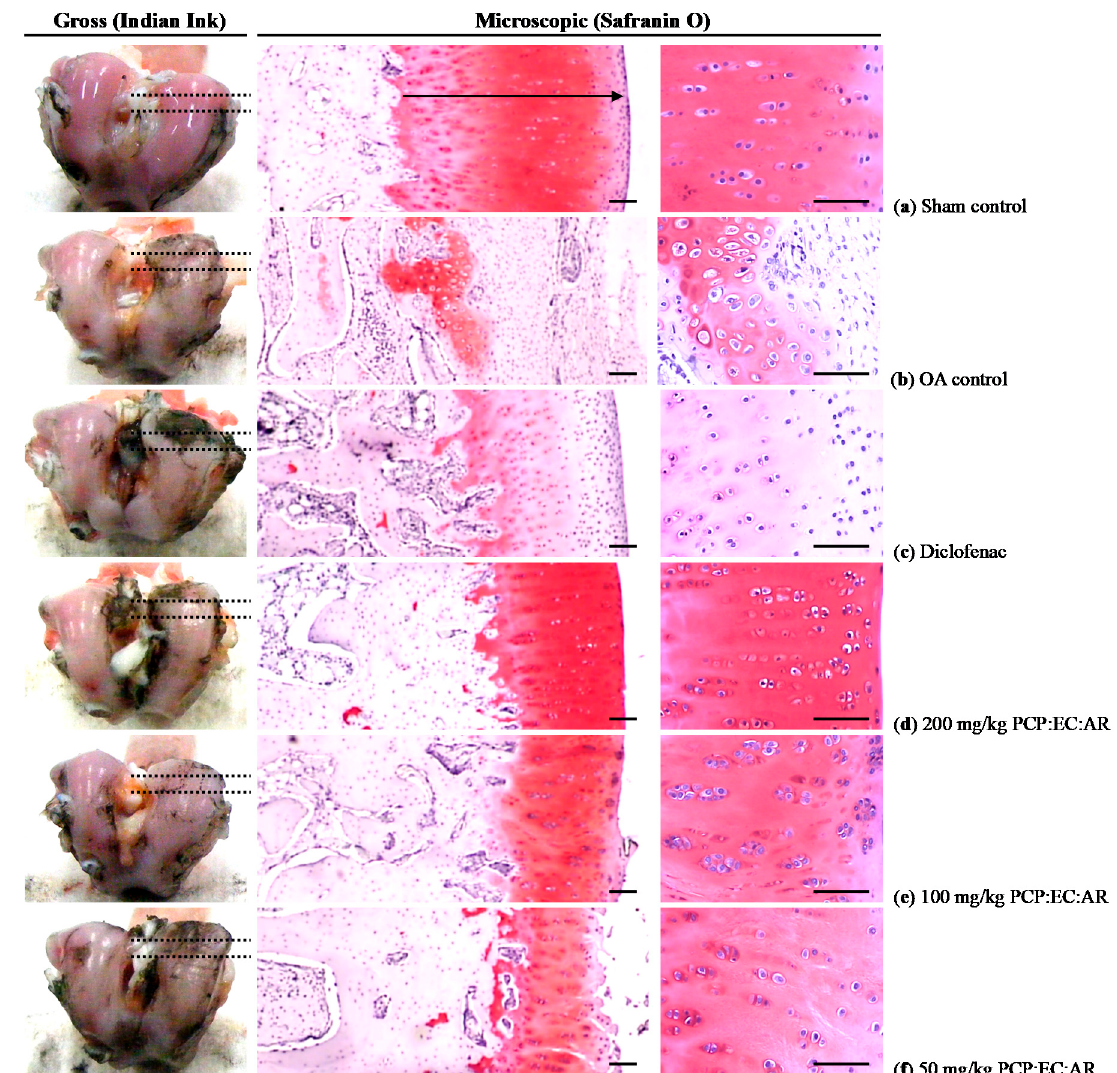
Figure 4. Representative gross and general histological images of the femur articular surface cartilages, taken from sham-operated or OA rabbits. ( a ) Sham vehicle control (sham-operated and distilled water orally administered rabbits); ( b ) OA control (OA-surgery and distilled water orally administered rabbits); ( c ) Diclofenac (OA-surgery and diclofenac sodium 2 mg/kg subcutaneously treated rabbits); ( d ) PCP:EC:AR mixed-formula 200 mg/kg orally administrated OA rabbits; ( e ) PCP:EC:AR mixed formula 100 mg/kg orally administrated OA rabbits; ( f ) PCP:EC:AR mixed formula